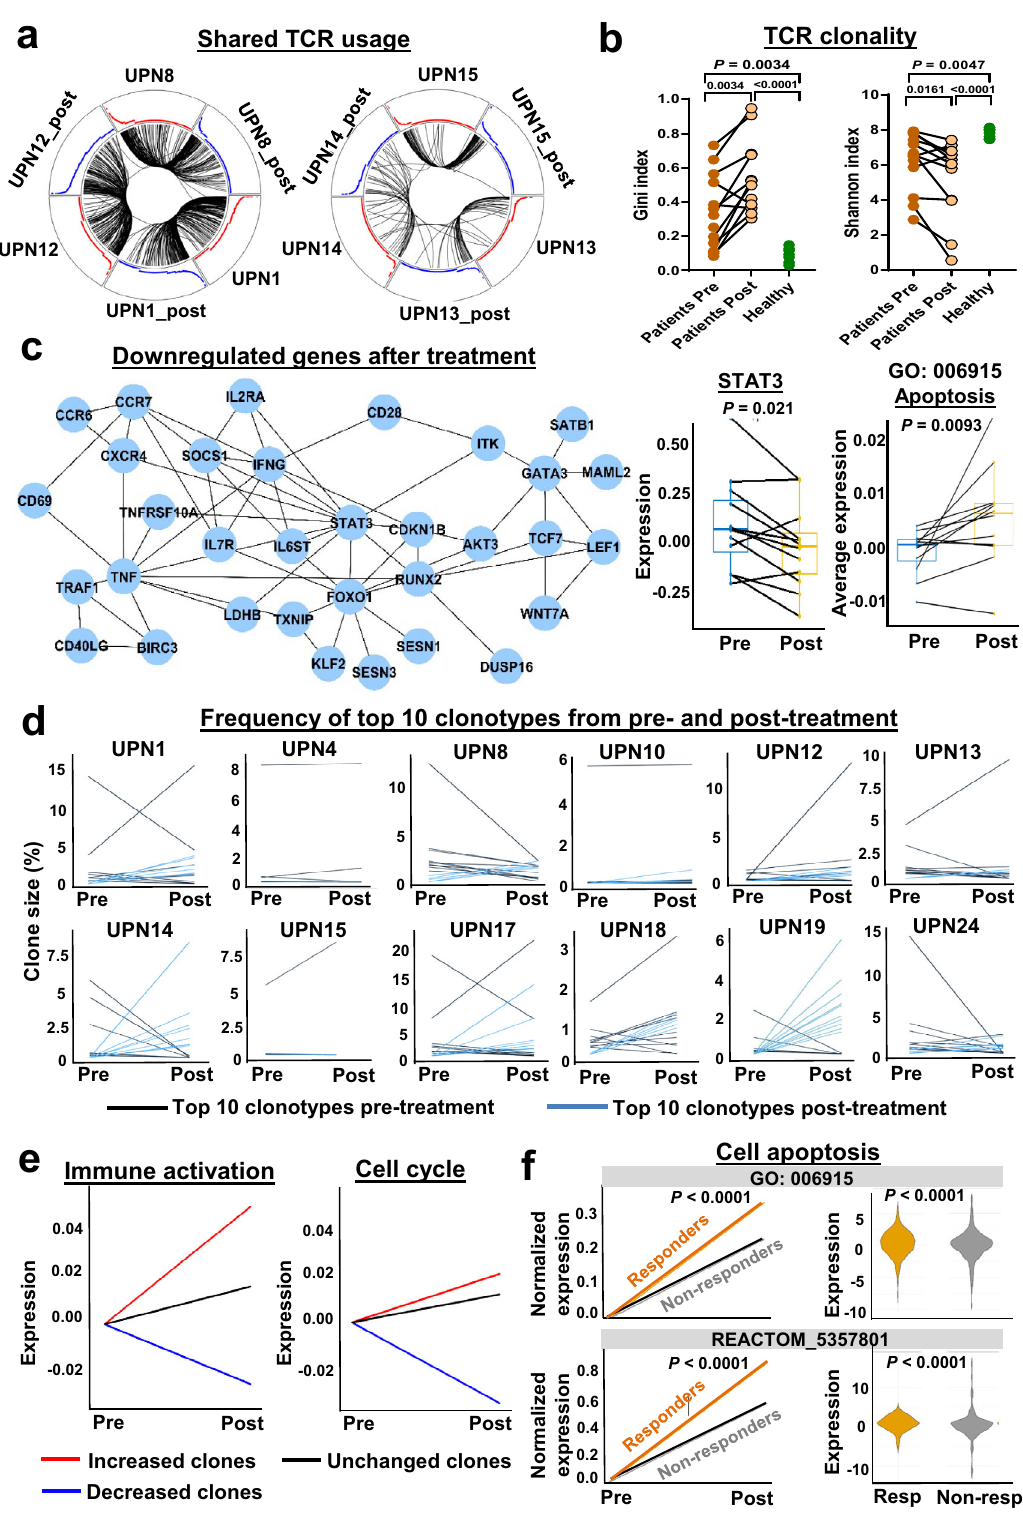
Top 10 clonotypes pre-treatment